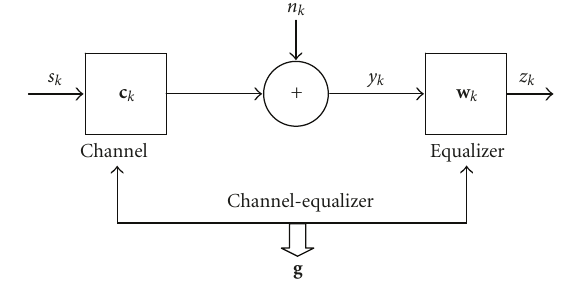
Figure 1: Block diagram of the